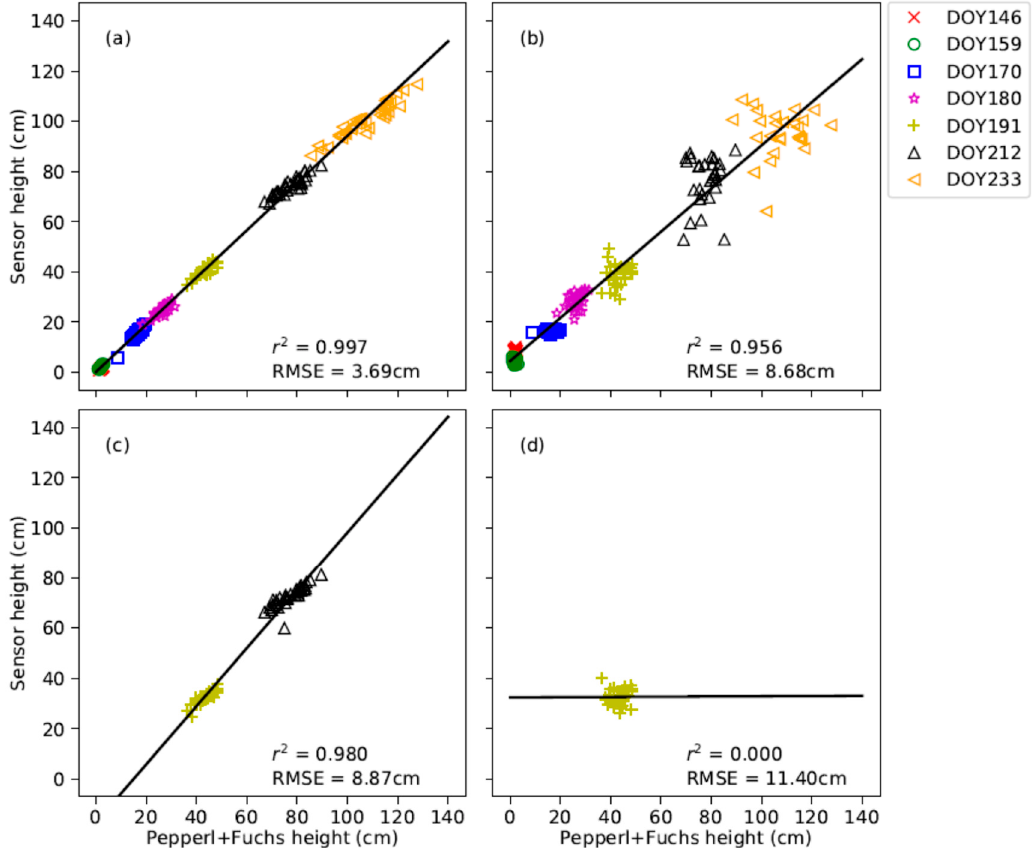
Figure 8. Pepperl+Fuchs (PF) derived plant height (cm) plot-level means compared to the Honeywell (HW) ( a ); LiDAR Lite v3 (LLt) ( b ); unmanned aerial system (UAS) ( c ); and LMS511 ( d ) height measurements for all 35 cotton entries grown at that Maricopa Agricultural Center in Maricopa, AZ in 2017.